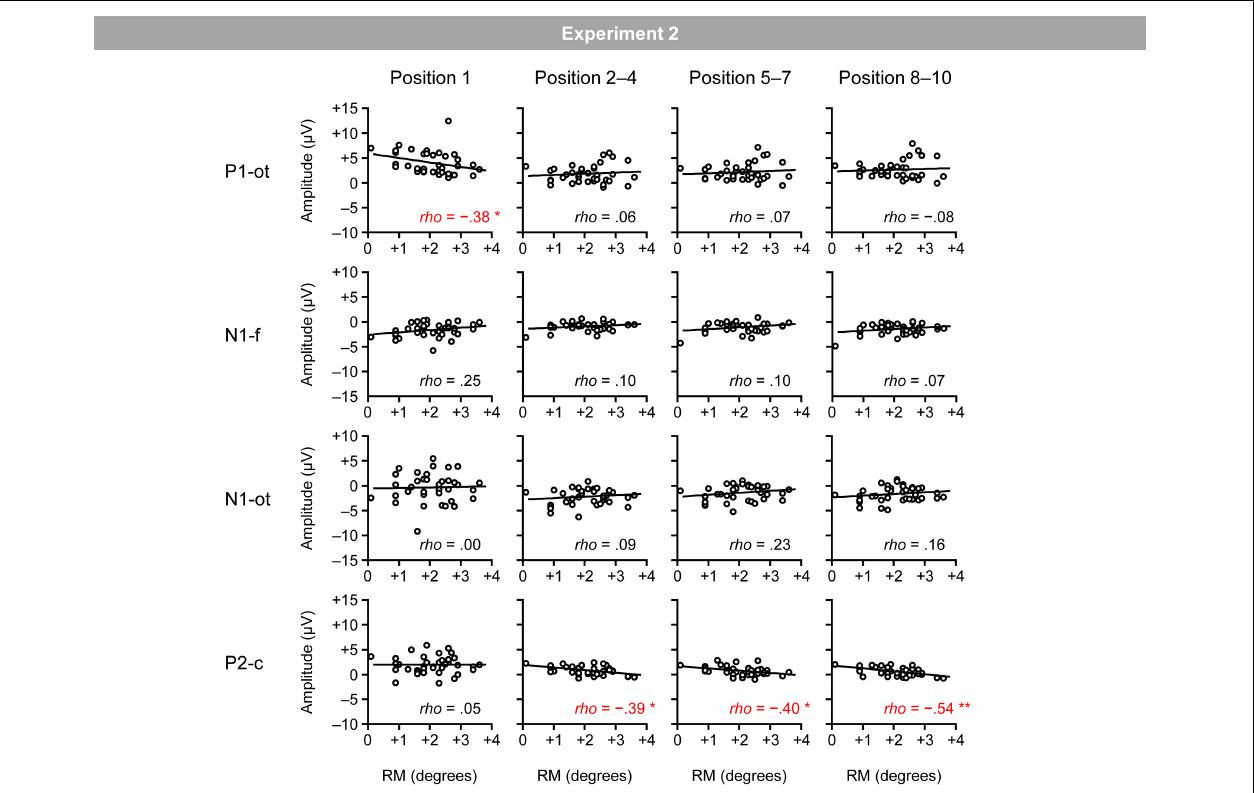
FIGURE 8 | Scatter plots of the relationships between the magnitudes of RM and VEPs. P1-ot: occipito-temporal P1, N1-f: frontal N1, N1-ot: occipito-temporal N1, P2-c: central P2. The linear regression fits to the data are shown. *Indicates p < 0.05 and **indicates p < 0.01 by Spearman’s correlation analysis